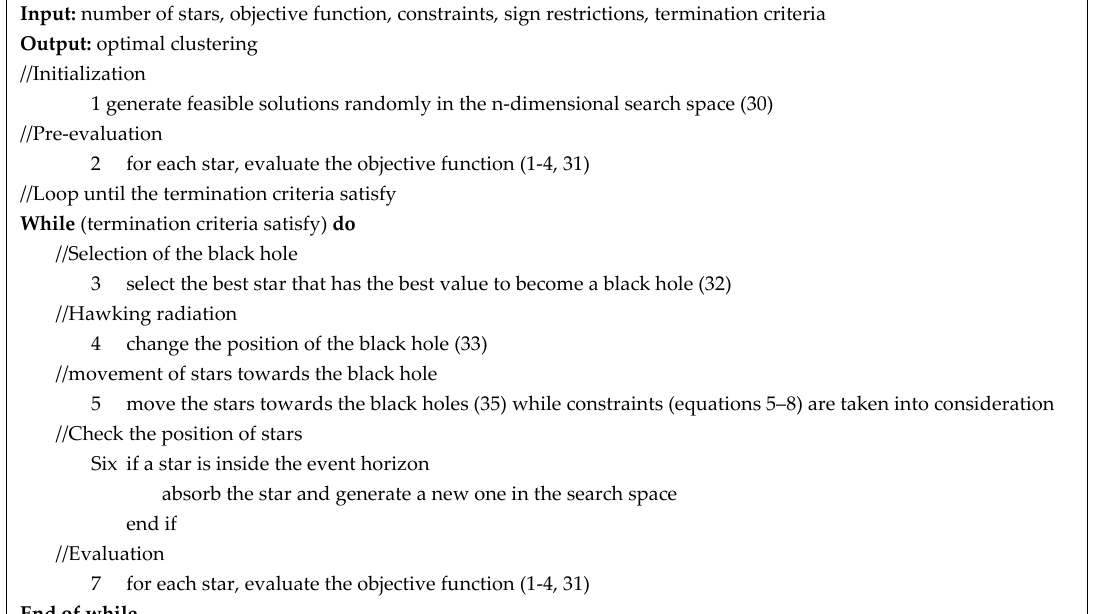
Figure 14. Pseudocode of the implementation of black hole algorithm for clustering of supply-demand in the extended phase of logistics resource optimization.